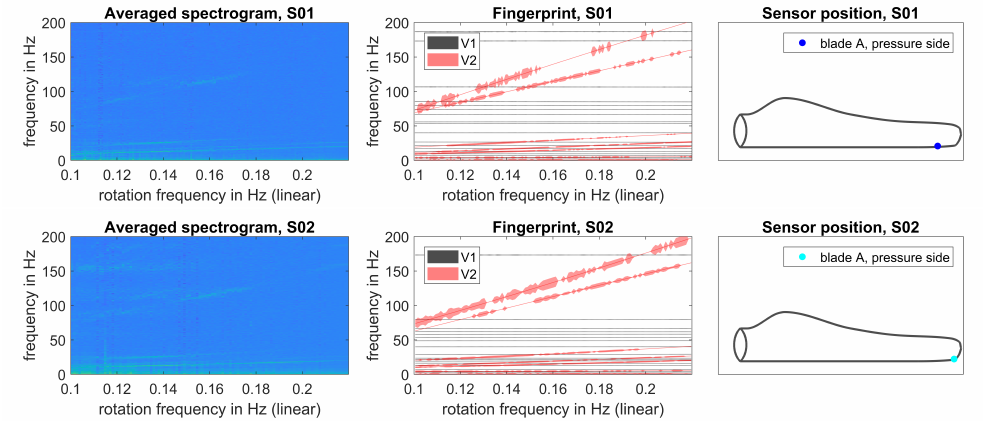
Figure 11. Fingerprint results for Sensors S 1 ( top ) and S 2 ( bottom ) mounted on the blade tip of test turbine 1. ( Left ) Linear-scale spectrogram with colour corresponding to logarithmic amplitude. ( Middle ) Extracted fingerprints, both Type 1 ( V 1) and Type 2 ( V 2) vibrations displayed. ( Right ) Sensor positions on the blade.